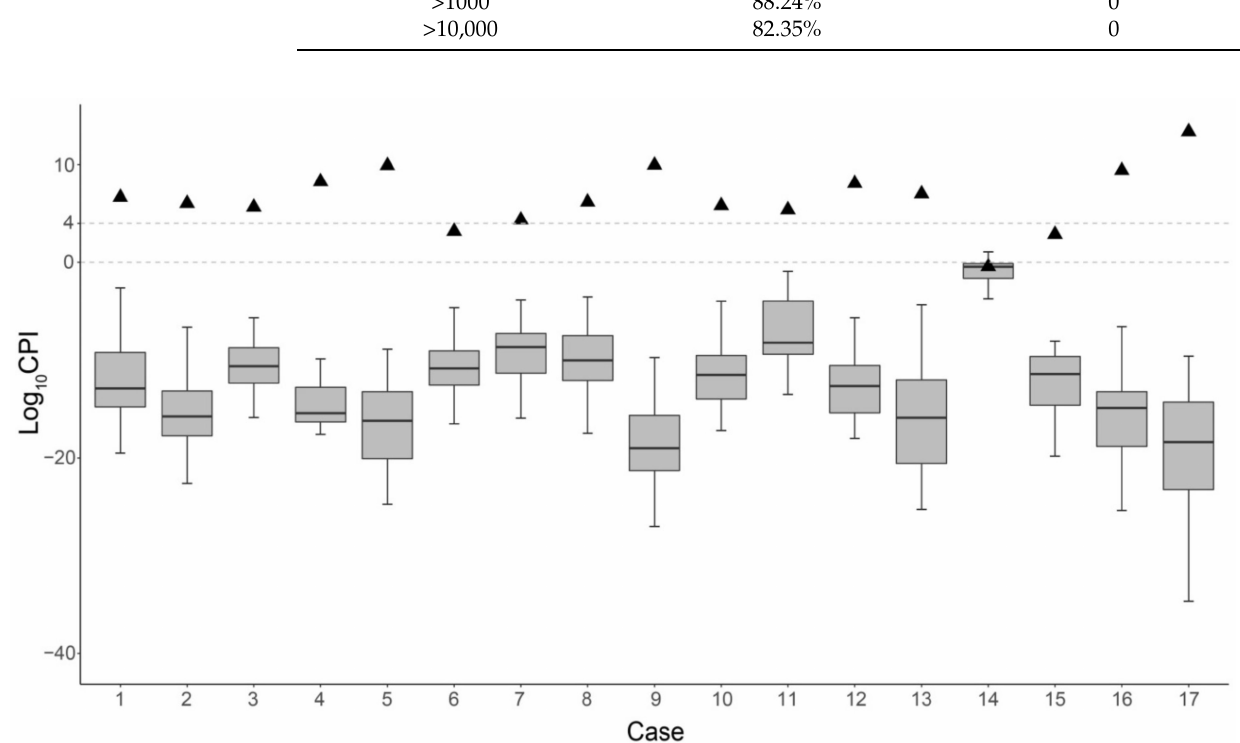
Figure 4. Log 10 CPI distribution in noninvasive prenatal paternity testing (NIPPT). Triangles represent the Log 10 CPI values obtained from 17 real trios. Boxplots show the distribution of Log 10 CPI values obtained from 272 unrelated